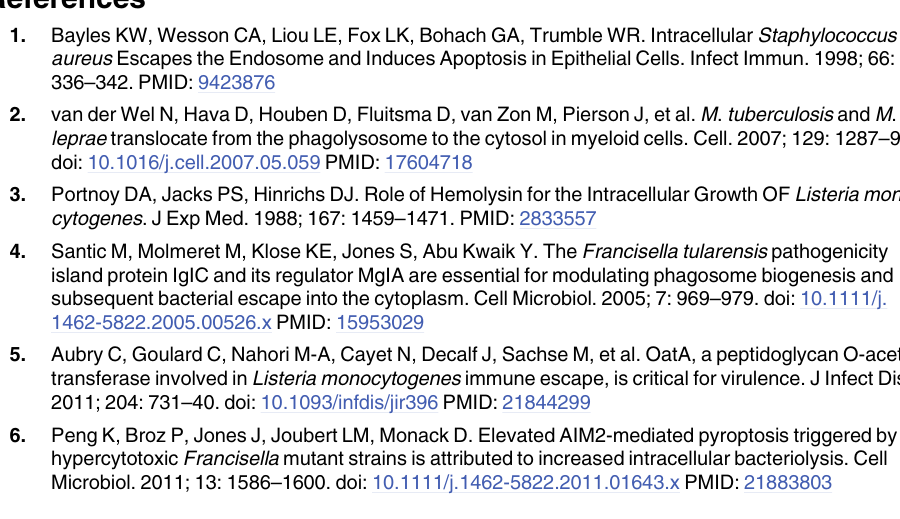
S5 Fig. PrkA autophosphorylatesitself on multiple sites. MS/MS spectra of PrkA phospho-